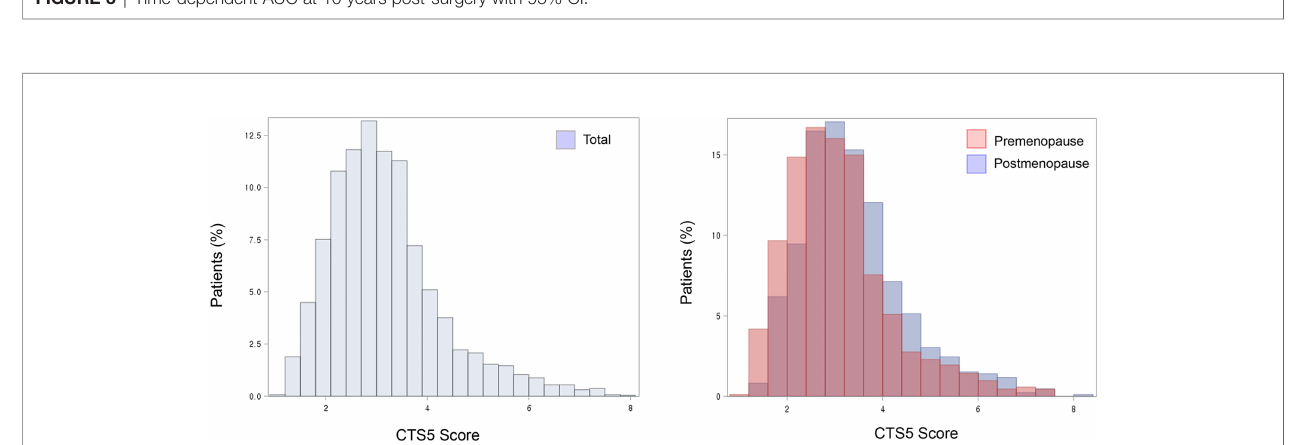
FIGURE 4 | Histogram of CTS5